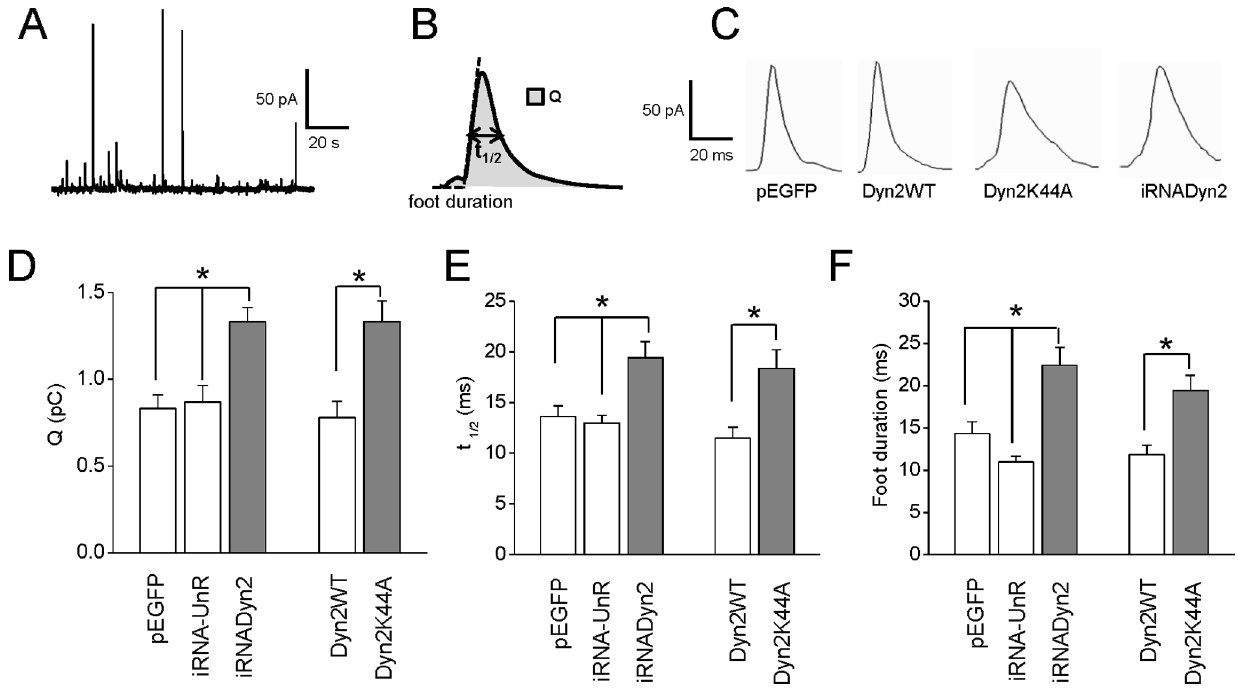
Figure 2. Endogenous dynamin-2 regulates the quantal release and expansion of the fusion pore. Exocytosis was evoked with 10 m M of the nicotinic agonist DMPP and monitored using amperometry. A : A typical amperometry trace in a single control chromaffin cell stimulated with 10 m M DMPP. B: Scheme of an amperometric spike with the analyzed parameters: quantal size (Q), half width (t 1/2 ) and foot duration. C : Typical amperometric spikes induced by 10 m M DMPP in cells transfected with pEGFP, Dyn2WT, Dyn2K44A or iRNADyn2. D–F : Data show average values 6 SEM of Q (C), t 1/2 (D) and foot duration (E) of amperometric events in cells transfected with pEGFP (n=35), iRNA-UnR (n=28), Dyn2WT (n=15) in white bars, and cells transfected with iRNADyn2 (n=29) or Dyn2K44A (n=18) in gray bars. All amperometric parameter values correspond to the median values of the events from individual cells, which were subsequently averaged per treatment group. Thus, n corresponds to the number of cells in each treatment group. Note that the down-regulation of dynamin-2 (iRNADyn2) or the inhibition of its GTP-ase activity (Dyn2K44A) significantly increased Q, t 1/2 and foot duration of the exocytotic events evoked by 10 m M DMPP. *p , 0.05 (Kruskal-Wallis test). doi:10.1371/journal.pone.0070638.g002 PLOS ONE |